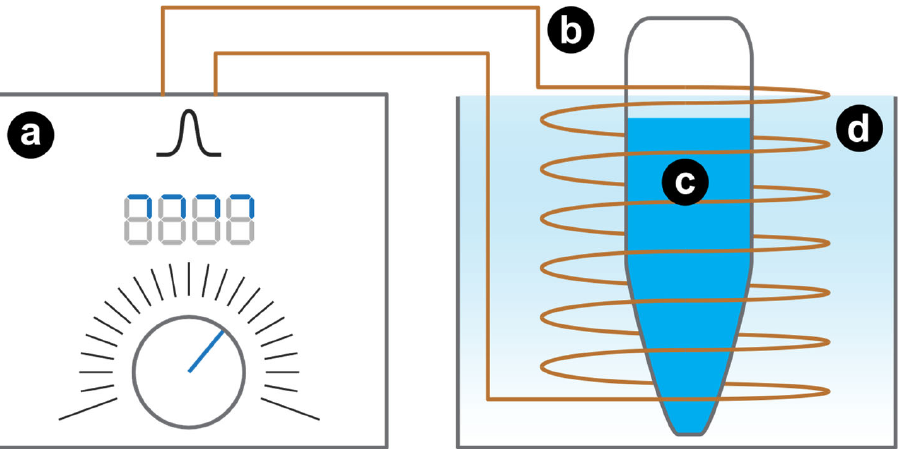
Figure 7. Illustration of the experimental set-up for the application of HI-PEMF in vitro. Custom-made HI-PEMF generator ( a ) was connected to an applicator consisting of a round coil ( b ) with 48 turns. The sterile 0.2 mL PCR standard tube containing the cell suspension ( c ) was placed inside the applicator ( b ). Both the applicator and the PCR tube were immersed in the ice bath ( d ) for the duration of the pulse delivery.